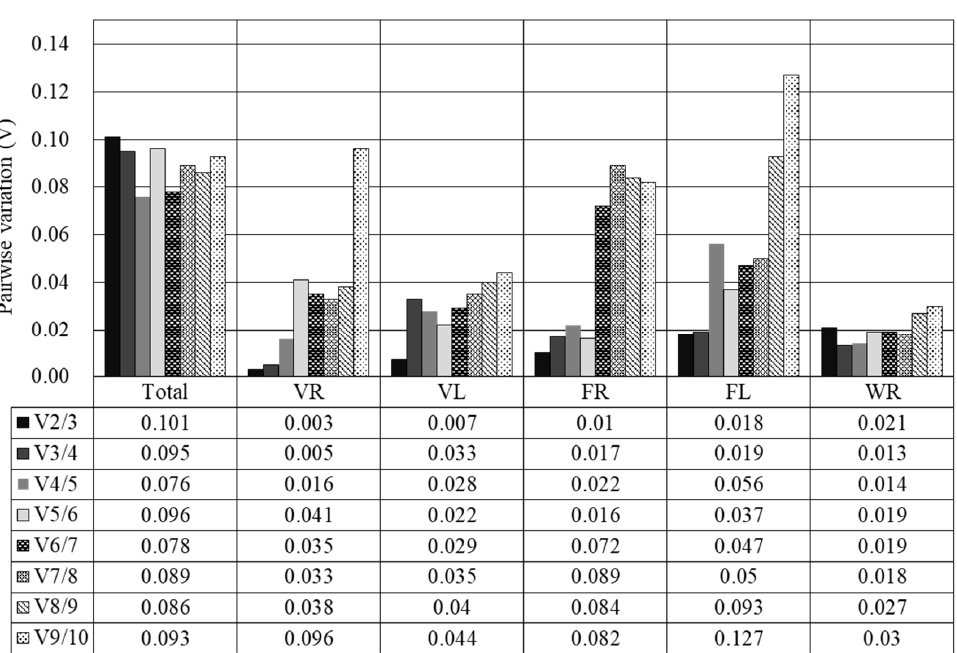
Figure 4. Determination of the optimal number of reference genes required for effective normalization. A pairwise variation (Vn/Vn+1) analysis between the normalization factors (NFn and NFn+1) was performed by the geNorm program to determine the optimal number of reference genes that might be carried out for RT ‐ qPCR data normalization in various sample pools. The statistical analysis of the expression stability was performed for all of the tested samples (Total) and separately for each growth stage for the rhizome samples and for the samples of the leaves of the cultivated and wild plants. Total: all rhizome and leaf samples of the cultivated and wild plants; VR: rhizomes at the vegetative stage; VL: leaves at the vegetative stage; FR: rhizomes at the flowering stage; FL: leaves at the flowering stage; WR: rhizomes at the withering stage.